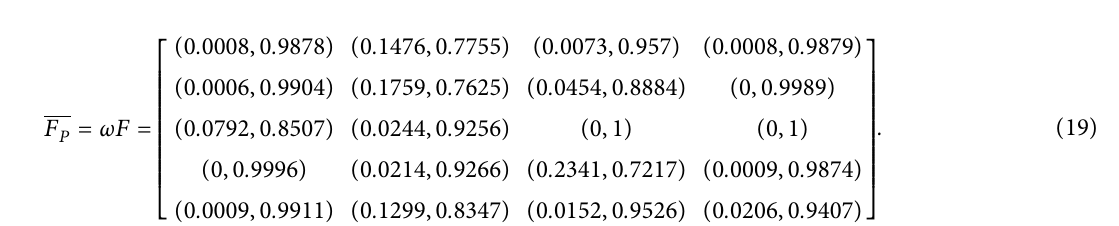
Figure 7: Nonmembership function of the rockburst intensity: (a) uniaxial compressive strength σ of shear stress and uniaxial compressive strength σ θ / σ c , (d) elastic strain energy index of rocks W et , and (e) integrity coefficients of the rock K mass v ) (